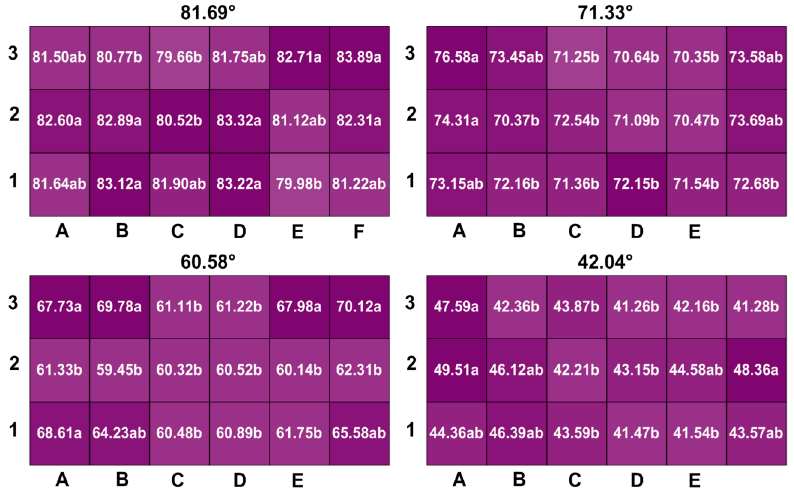
Figure 15. Spatial distribution of droplet landing angle of throughfall. Different letters indicate sig- nificant difference between data in each treatment ( p < 0.05).